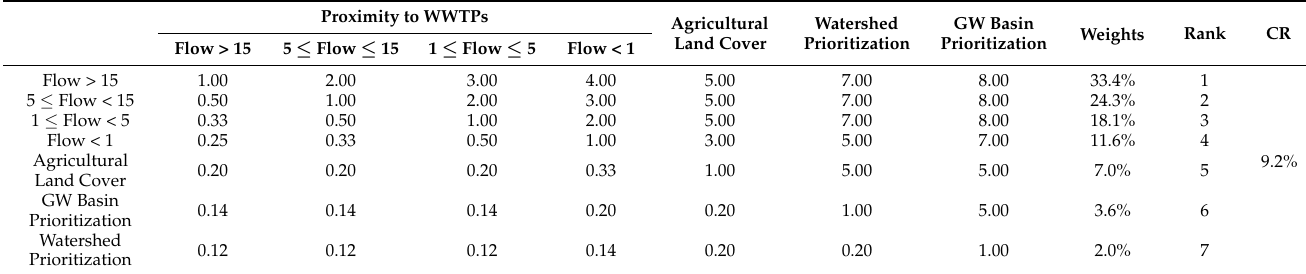
Table 6. Pairwise matrix for the decision criteria for Case 3: considering the appropriate treatment process. Consistency Ration (CR) was calculated based on the Equation